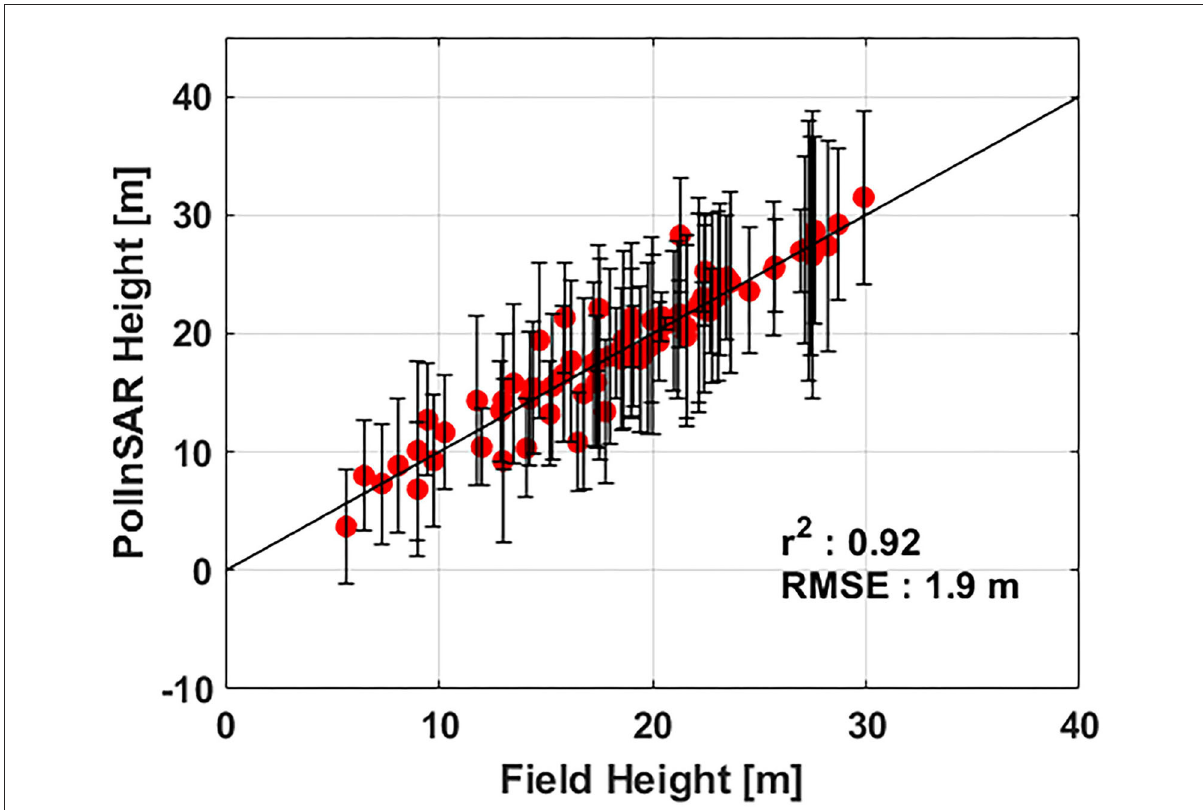
FIGURE11 Validation of optimum height vs. field height. The vertical error bars represent